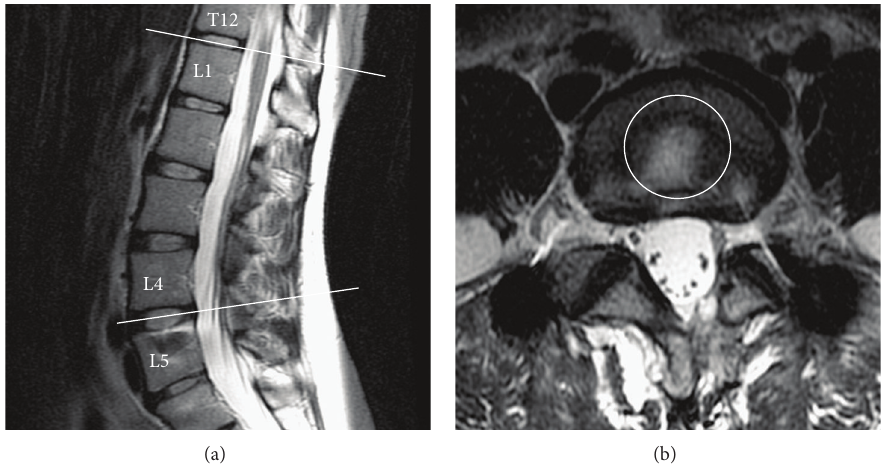
Figure 2: MRI T2-weighted image of a 34-year-old female. (a) Sagittal view. (b) Axial view. The axial view of each disc was retrieved in correspondence with the center of each disc in sagittal view. A circle of one centimeter in radius, region of interest (ROI), was drawn in the geometrical center of each disc. The mean signal intensity of ROI was then measured and recorded. The mean signal intensity of ROI of each level (e.g., L4-5) divided with reference level (i.e., T12-L1) was called